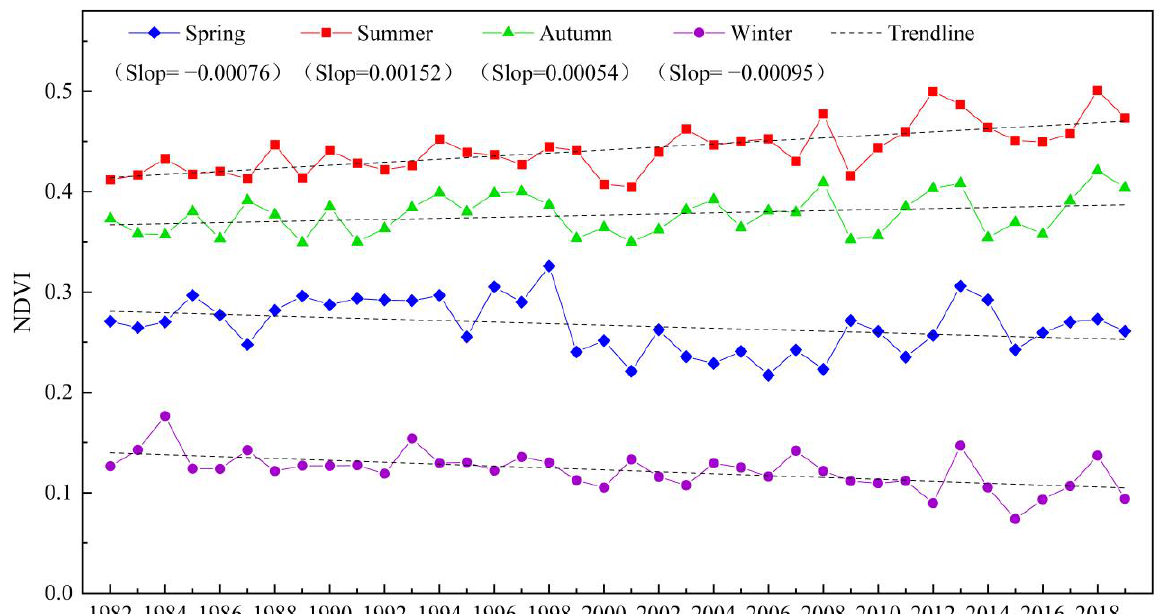
Figure 6. Change trend of NDVI in four seasons over time. The slopes of trend lines in spring, summer, autumn, and winter are − 0.00076, 0.00152, 0.00054, and − 0.00095, respectively ( p < 0.05).